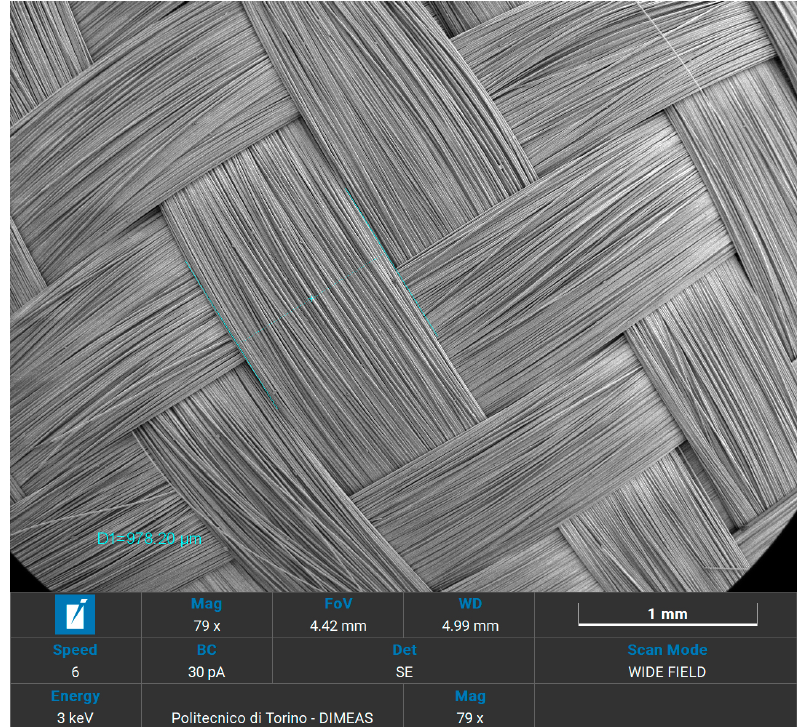
Figure 10. Recycled Basalt Fiber Woven Fabric.